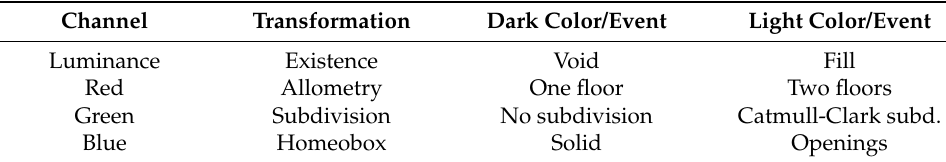
Figure 4. Evolution of the evo-devo model. From left to right: color-pattern (genotype), cells creation based on luminance, allometry (heights) based on red channel, subdivision (tiles) based on green channel, homeotic genes (openings) based on blue channel and final geometry (phenotype).